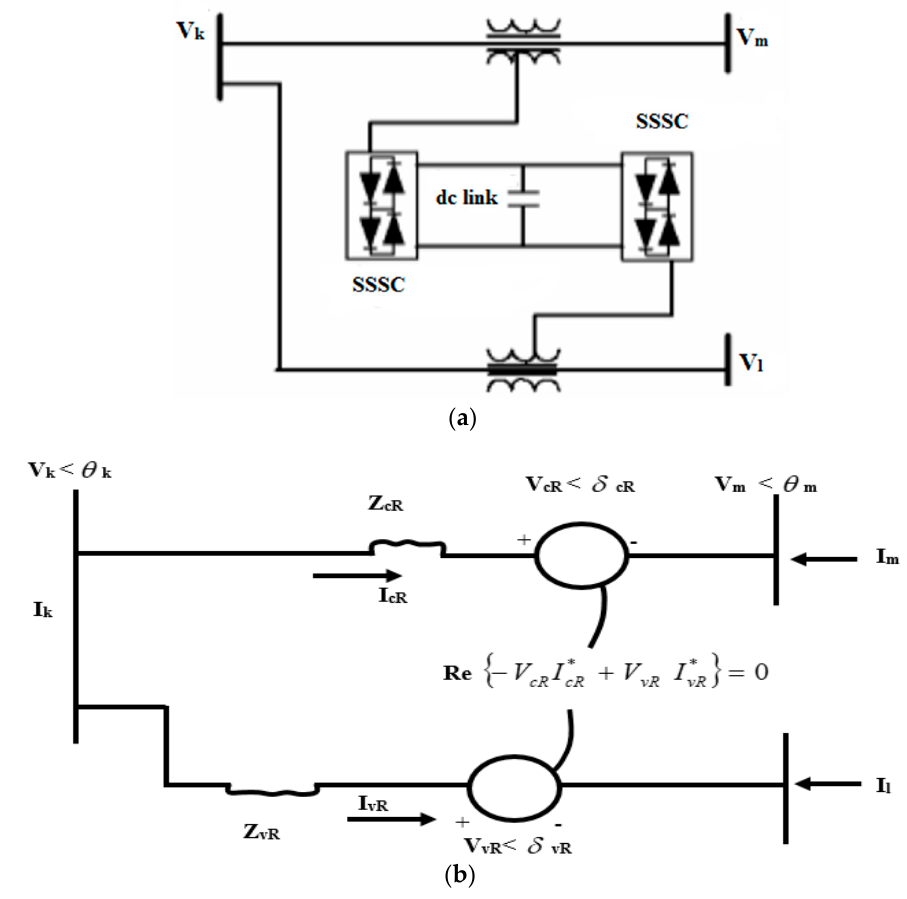
Figure 2. IPFC. ( a ) Schematic diagram; ( b ) equivalent circuit [33,34].